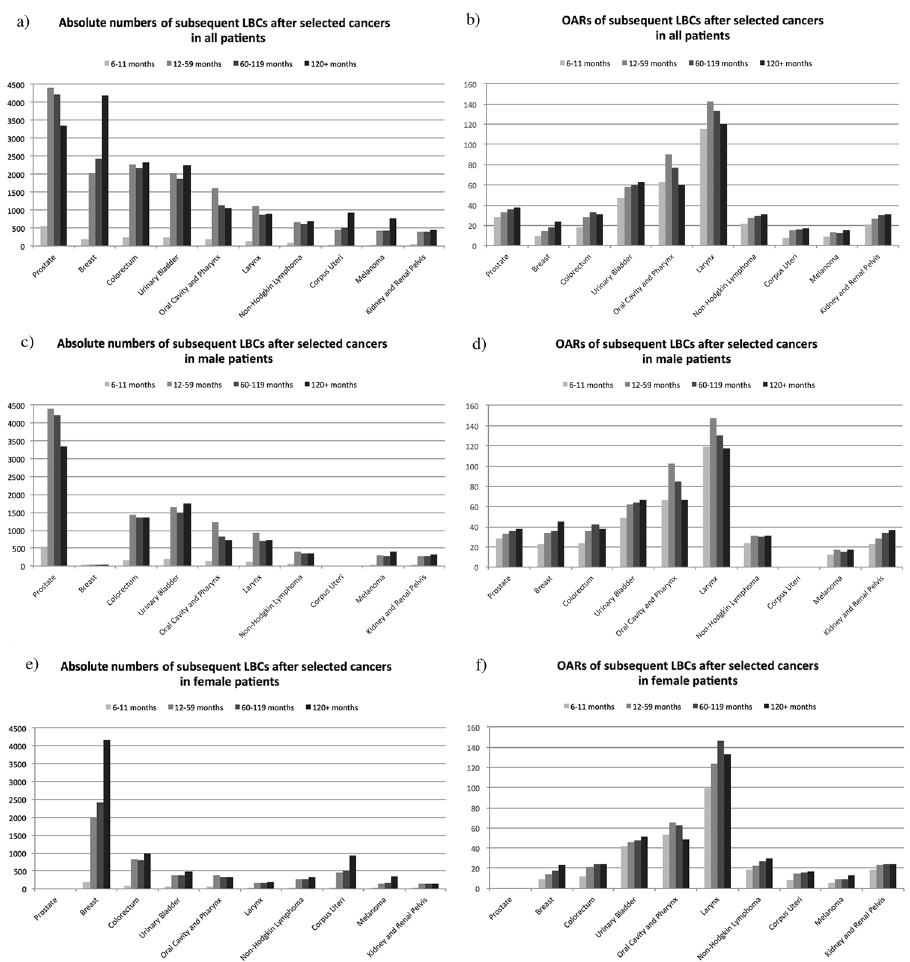
Figure 3. Absolute numbers and observed annual risks (OARs) of subsequent lung and bronchus caners (LBCs) after selected cancers, by latency and